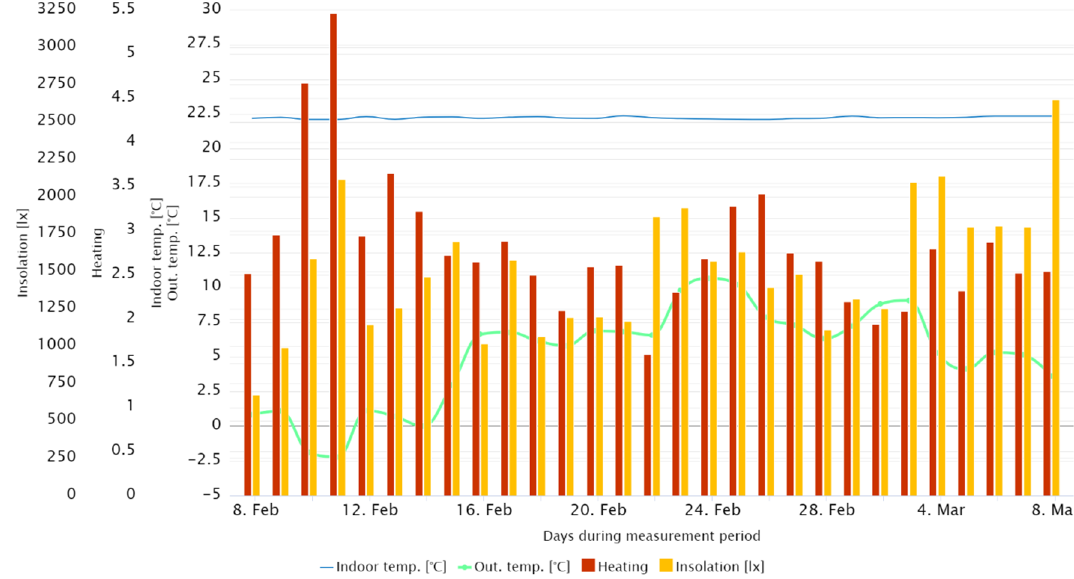
Figure 8. Daily averages of the internal temperature for room 140 referring to heating valve position, insolation, and outdoor temperature.